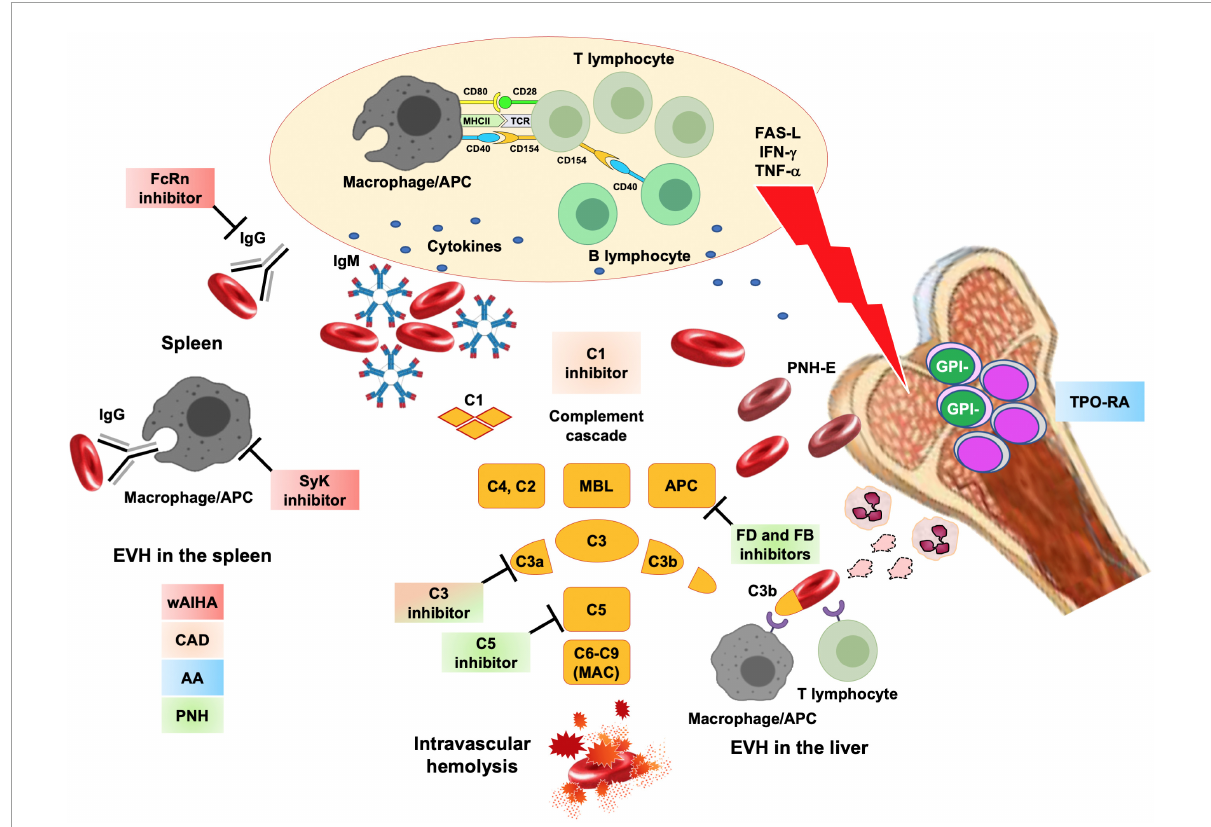
FIGURE2 Novel drugs for rare acquired anemias and their targets. Acquired anemias encompass autoimmune hemolytic anemias, where hemolysis is due to autoantibodies produced after a tolerance break with altered B-, T- cells and antigen presenting cells (APC) crosstalk and production of several cytokines. In warm forms (wAIHA), IgG autoantibodies cause extravascular hemolysis (EVH) in the spleen. These processes may be targeted by neonatal Fc receptor inhibitors (FcRn that clear the autoantibodies from the circulation) and spleen tyrosine kinase (SyK) inhibitors (which inhibits phagocytosis). In cold agglutinin disease (CAD), IgM activate the classical complement cascade and cause C3d mediated extravascular hemolysis in the liver and minor C5 mediated intravascular hemolysis. This may be targeted by complement inhibitors (particularly C1 and C3 inhibitors). Even in wAIHA complement activation may occur and complement inhibitors are under study. Aplastic anemia (AA) is due to a T-cell attack to hematopoietic stem cells, through exposure/release of mediators such as FAS, interferon gamma (IFN) and tumor